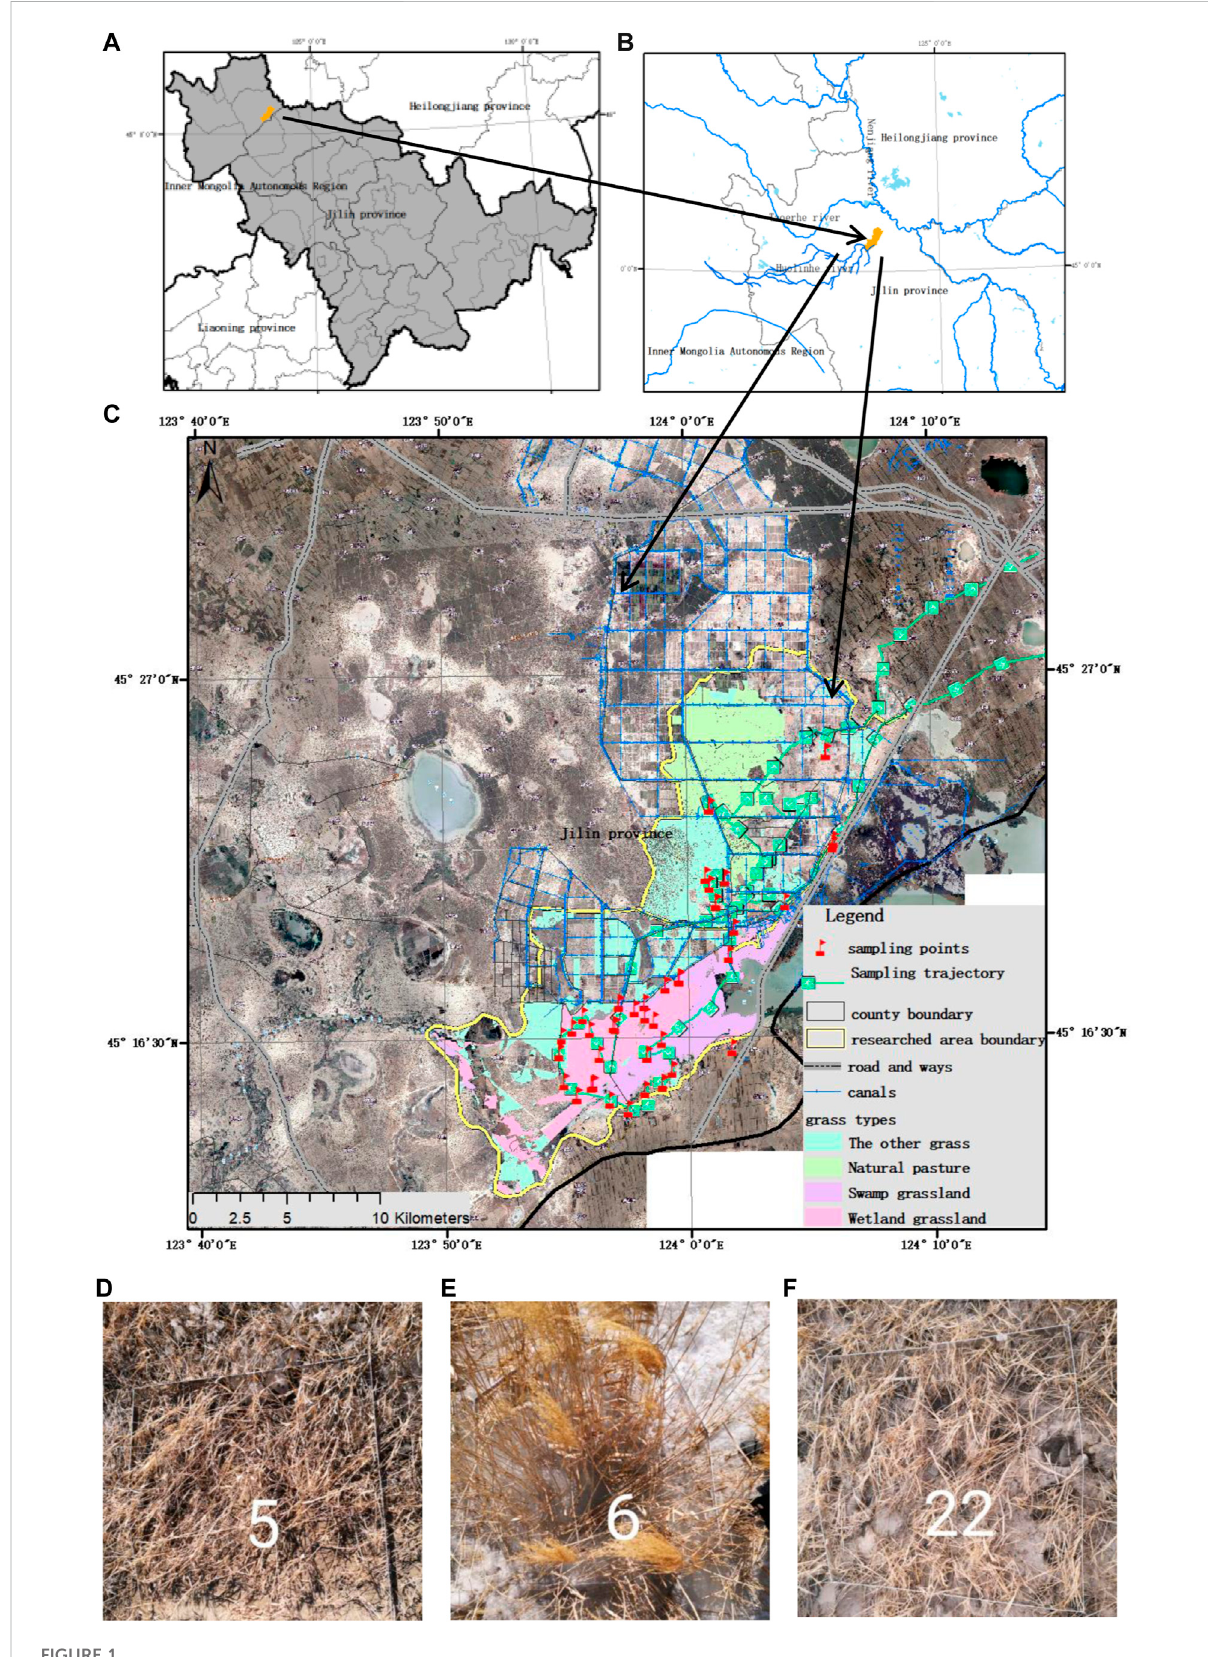
FIGURE 1 Schematic diagrams (A,B) and satellite images (C – F) showing the location of the study area and sampling